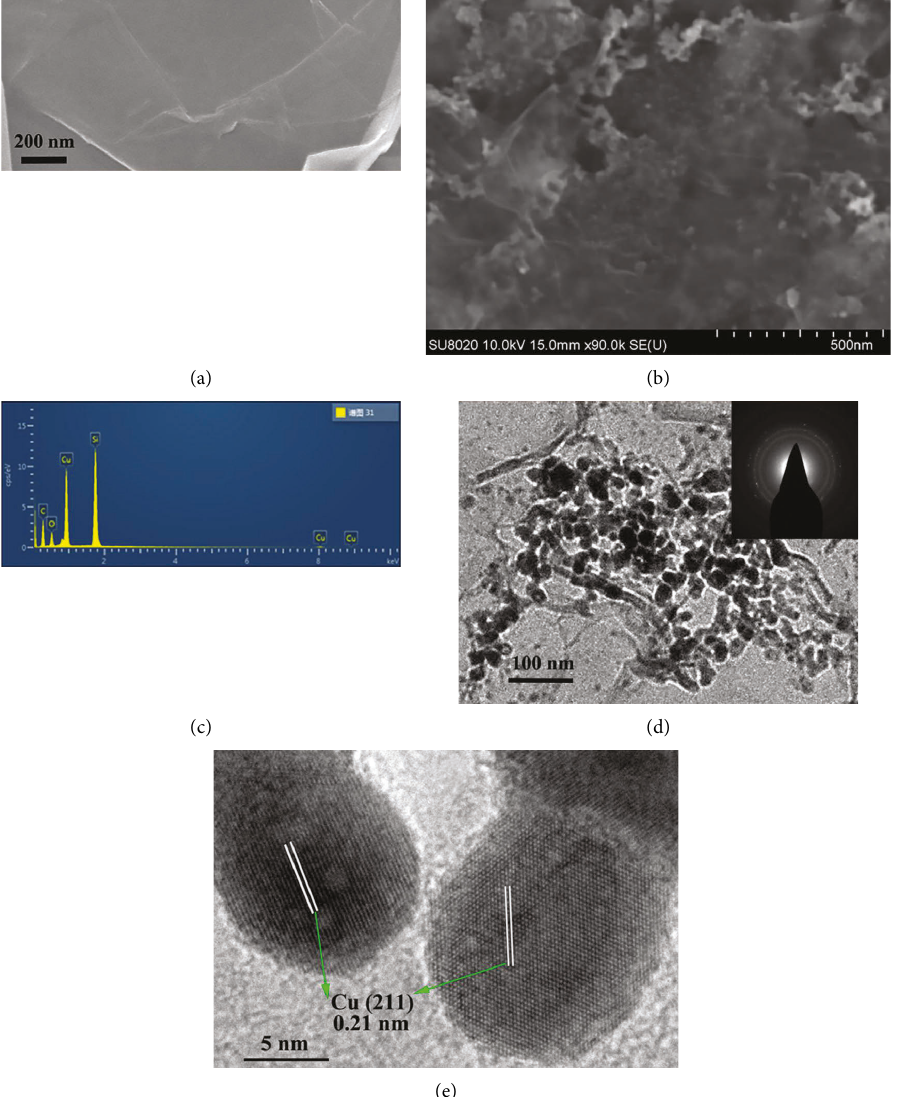
Figure 2: SEM, EDX, TEM, and HRTEM images of